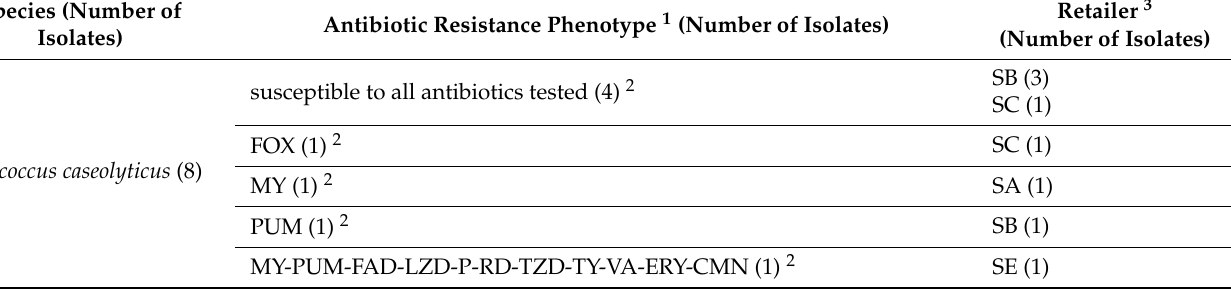
Retailer 3 (Number of Isolates)